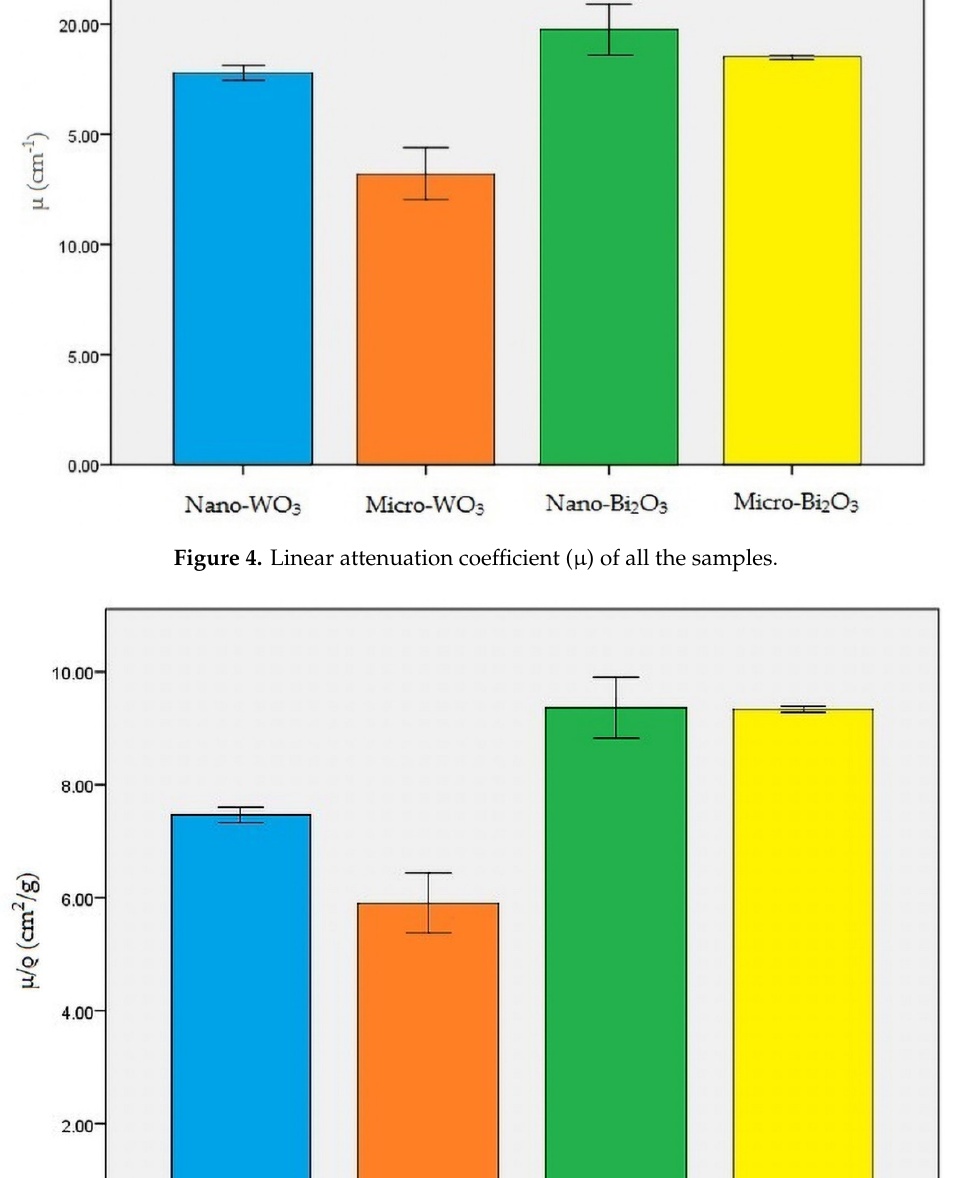
Figure 5. Mass attenuation coe ffi cient ( µ / (cid:37) ) of all the